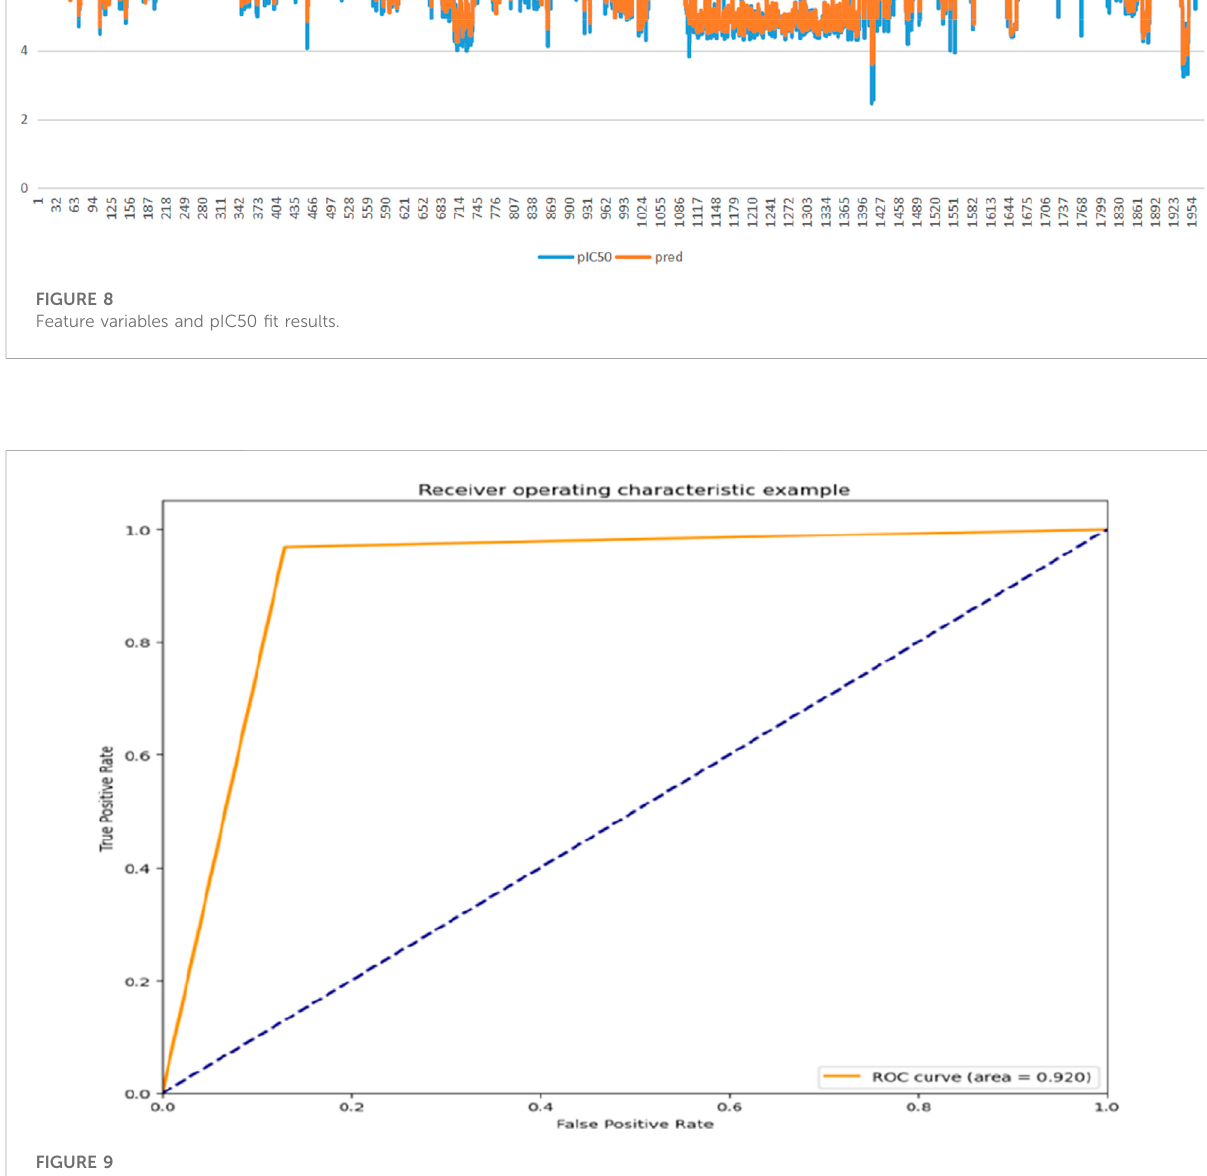
FIGURE 9 Classi fi cation model roc curve with hERG as the target value.